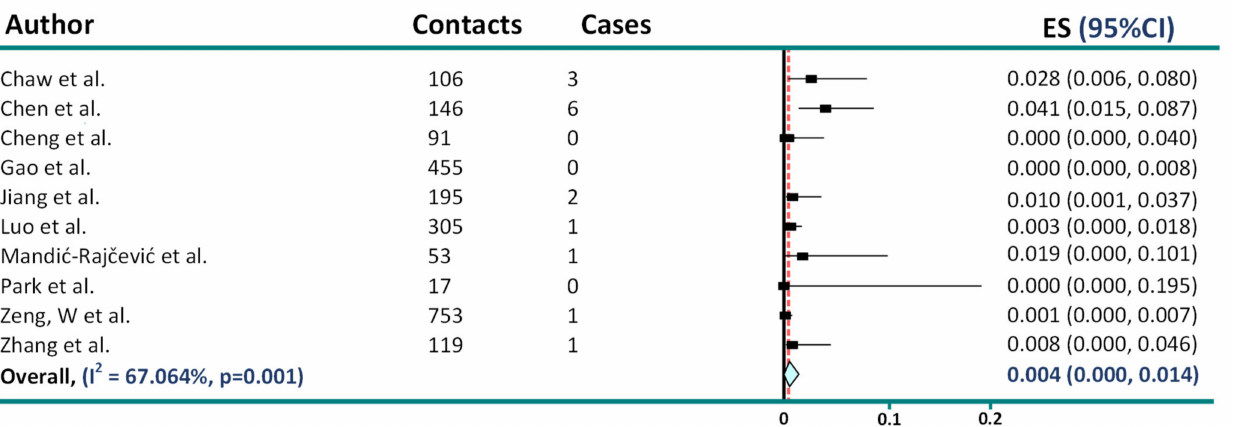
Figure 3. Reanalysis of secondary attack rates from truly asymptomatic and presymptomatic trans- mission